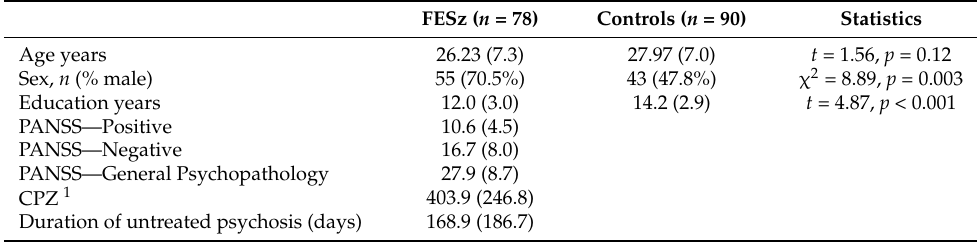
Table 1. Mean (SD) of demographic and clinical characteristics of